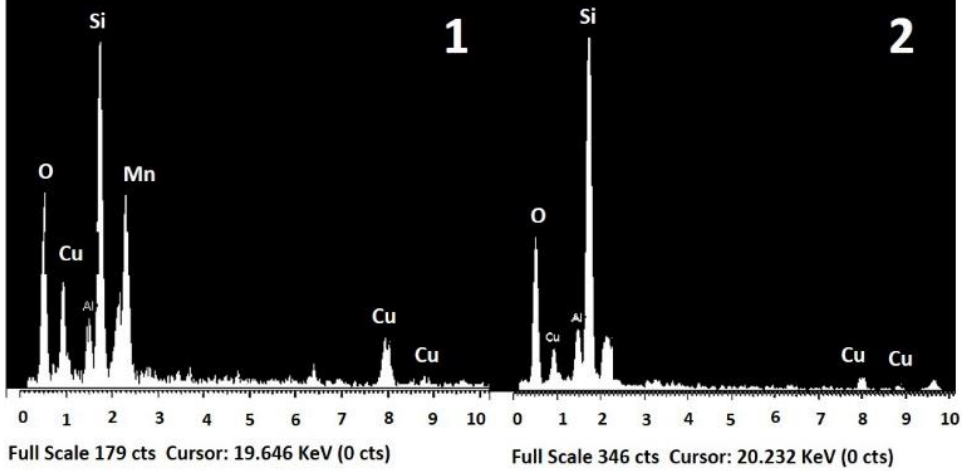
Figure 7. EDS analysis associated with Figure 6. Particles identified: copper pitch (1) and chrysocolla (2).